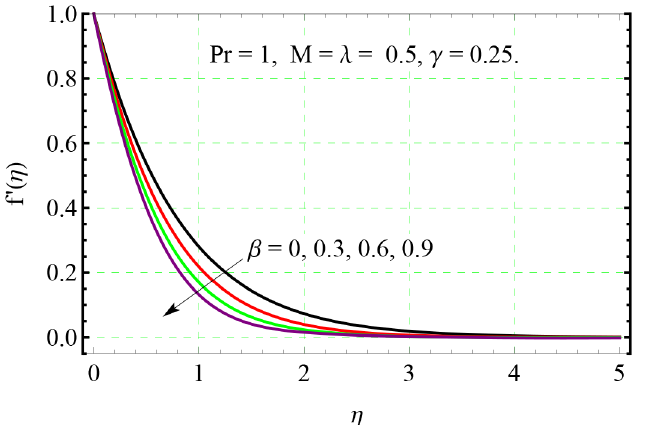
Fig 3. Effect of β on f 0 ( η